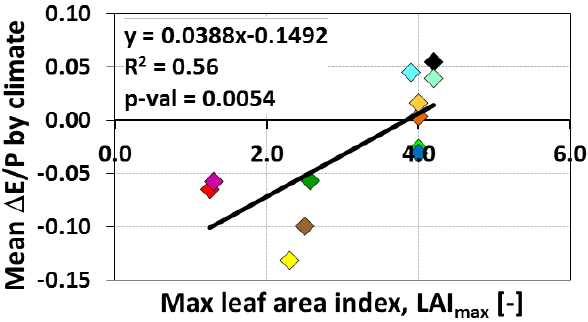
Fig. 8. Correlations between mean 1E/P by climate and two Figure 8 model parameters, vegetation root fraction and vegetation light use efficiency (sample size: 12; p value: 0 and 0.001, resp.).